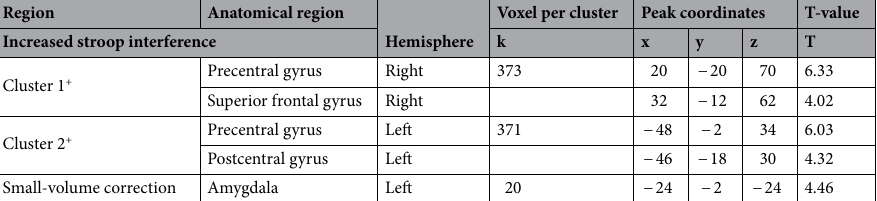
Region Anatomical